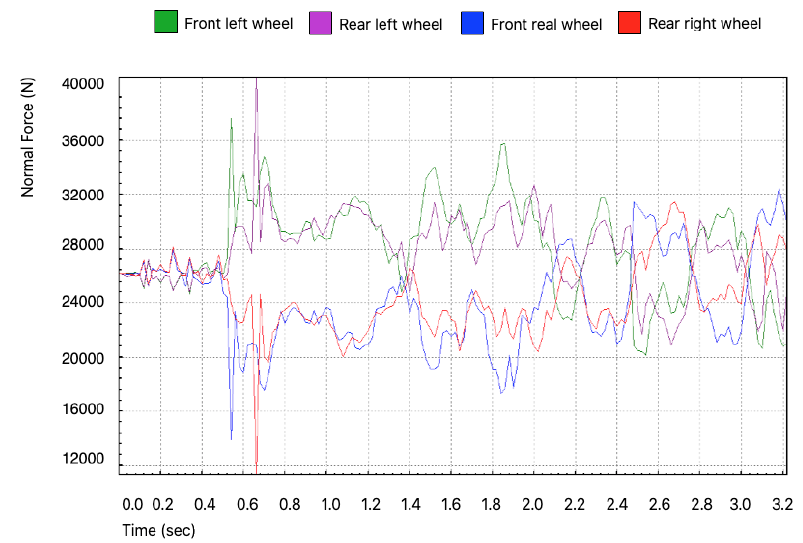
Figure 17. Normal force for conventional deflection (L = 3500 mm) .